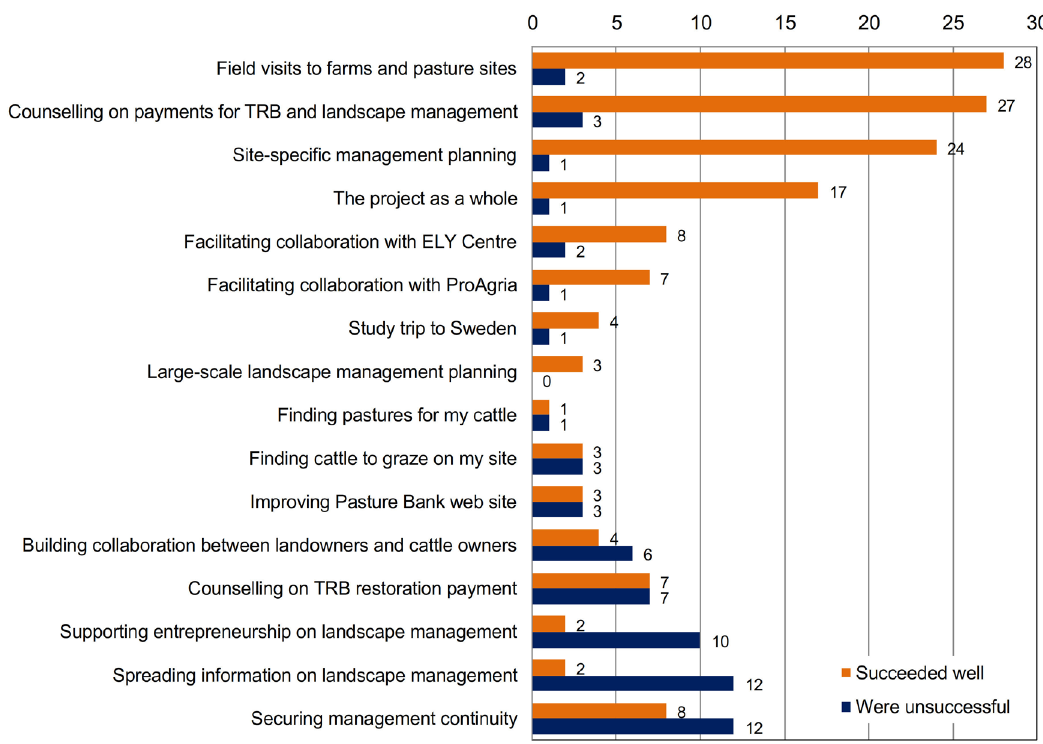
Figure 5: Activities of the project that were considered either successful or unsuccessful. First, respondents were asked to choose three activities they had experienced most positive (numbers of mentions are depicted in orange bars; n list of activities was presented again and participants chose which three project activities failed based on their experience (blue